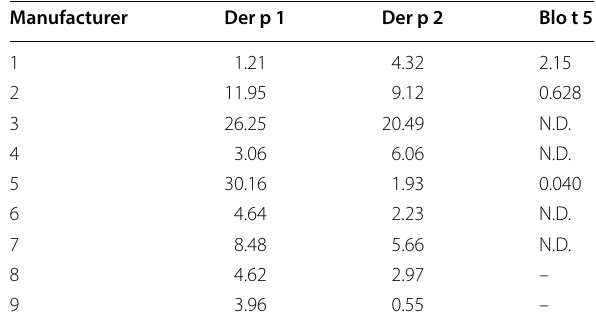
Table 2 Major allergens content (Der p 1, Der p 2 and Blo t 5) in commercial extracts from manufacturers 1 to 9.